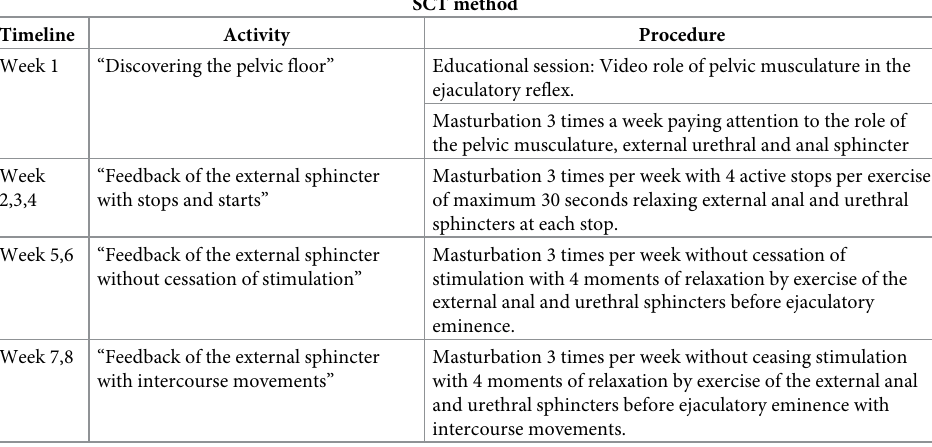
Table 2. Sphincter Control Training program